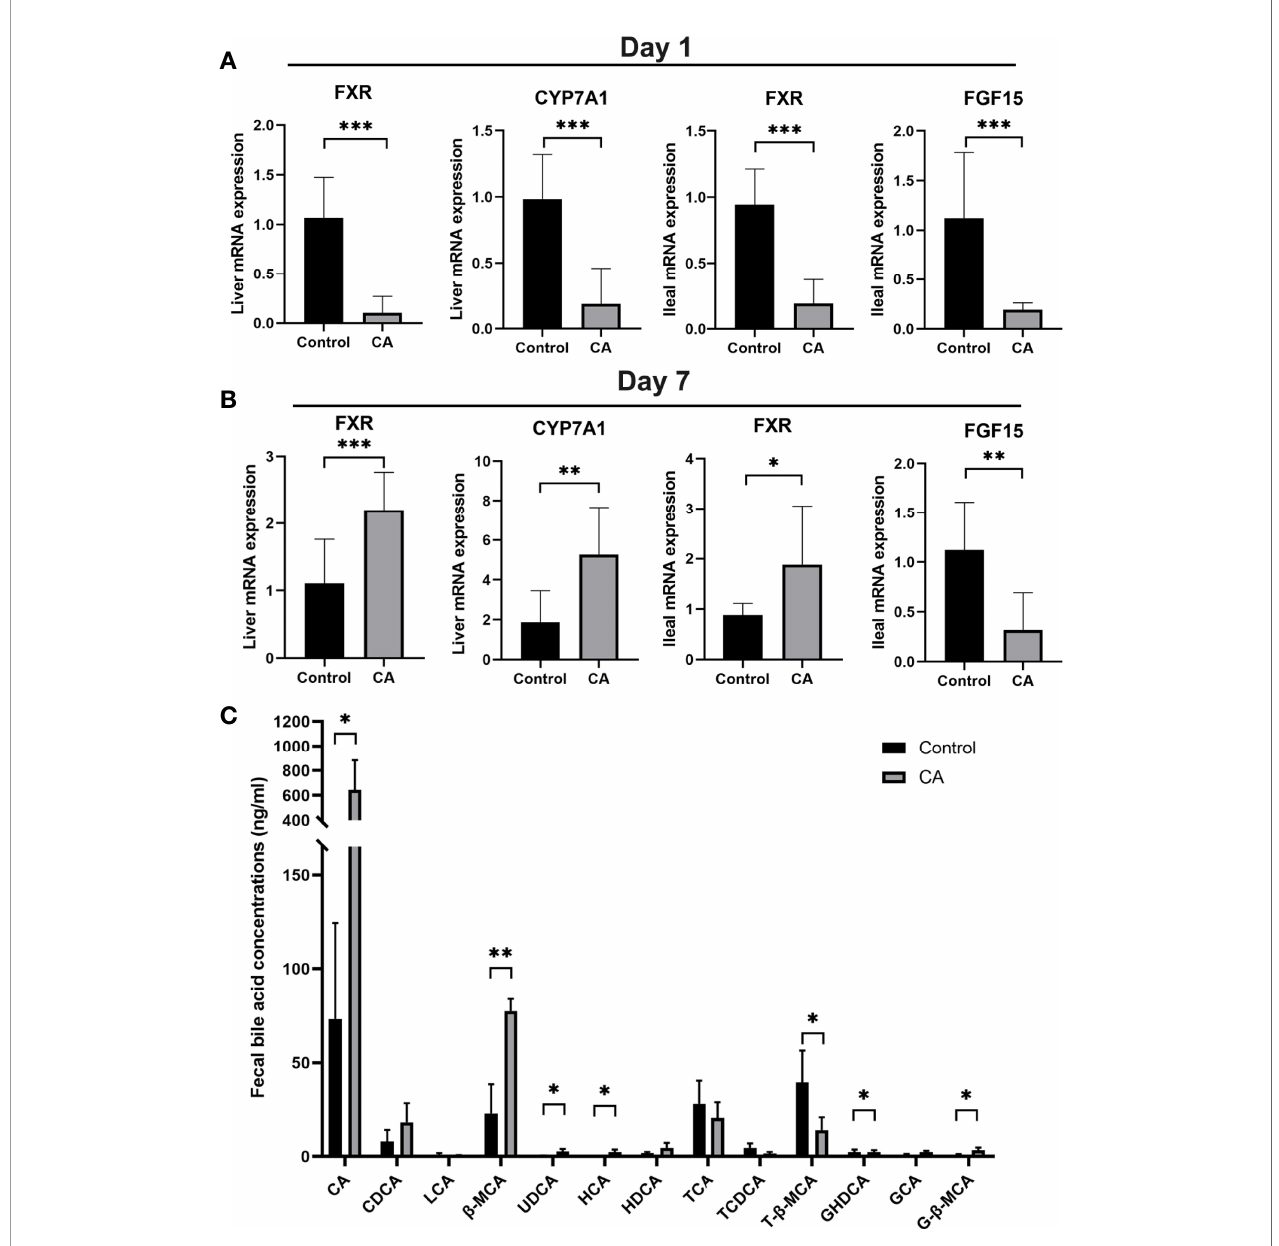
FIGURE 3 | Enterohepatic circulation of bile acid is dysregulated in the offspring from CA-fed mothers. (A) Relative mRNA expression levels of FXR, CYP7A1 in liver and FXR, FGF15 in ileum of fi rst day offspring from CA-fed mothers. (B) Relative mRNA expression levels of FXR, CYP7A1 in liver and FXR, FGF15 in ileum of seven days offspring from CA-fed mothers. (C) Major bile acids found in feces. *p < 0.05, **p < 0.01, ***p<0.001. N =